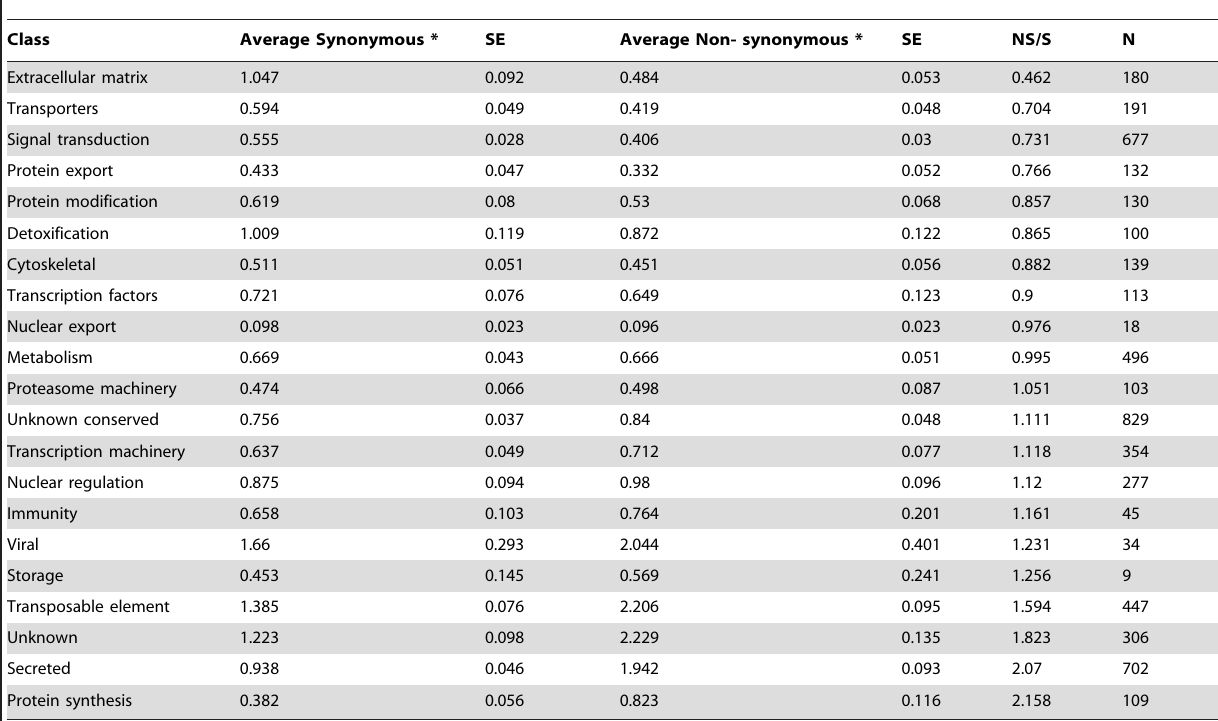
Table 12. Polymorphisms detected on the Triatoma infestans sialotranscriptome according to functional class.